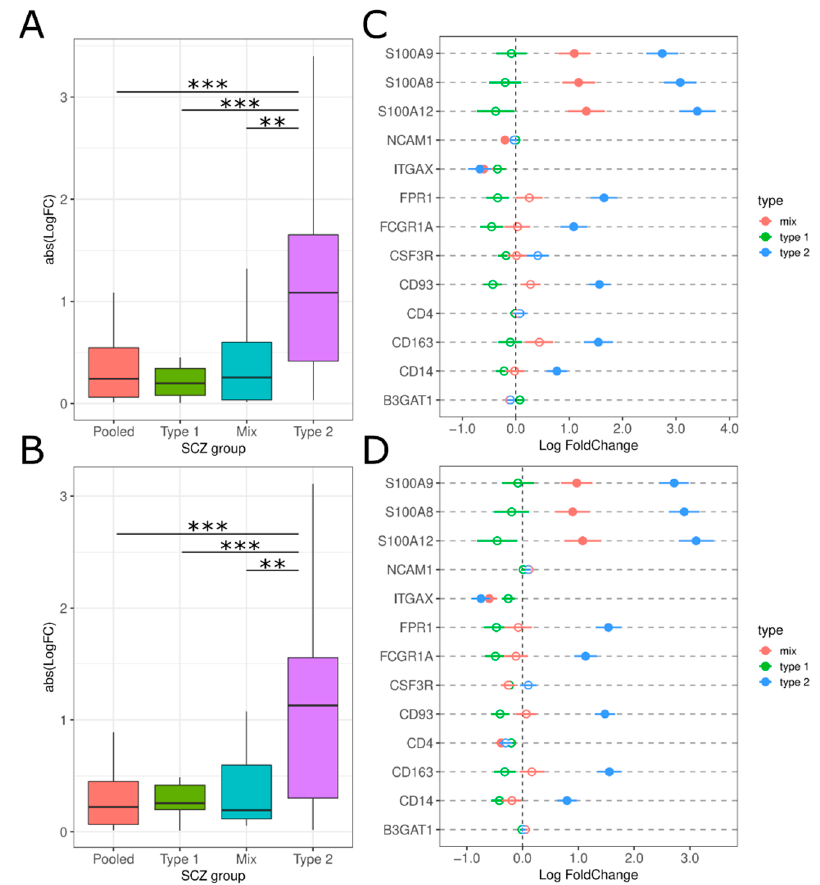
Figure 10. Peripheral immune expression in the SCZ groups. ( A , B ) Absolute LogFC value for peripheral markers for each SCZ group for polyA and riboZ, respectively. ** p -value < 0.01, *** p -value < 0.001 via Tukey HSD. ( C , D ) LogFC for each peripheral marker across SCZ subtypes for polyA and riboZ, respectively: Type 2 (blue), Mix (red), Type 1 (green). Lines indicate standard error. Filled circles = differentially expressed (Benjamini-Hochberg p -value < 0.05), empty circles = not differentially expressed.